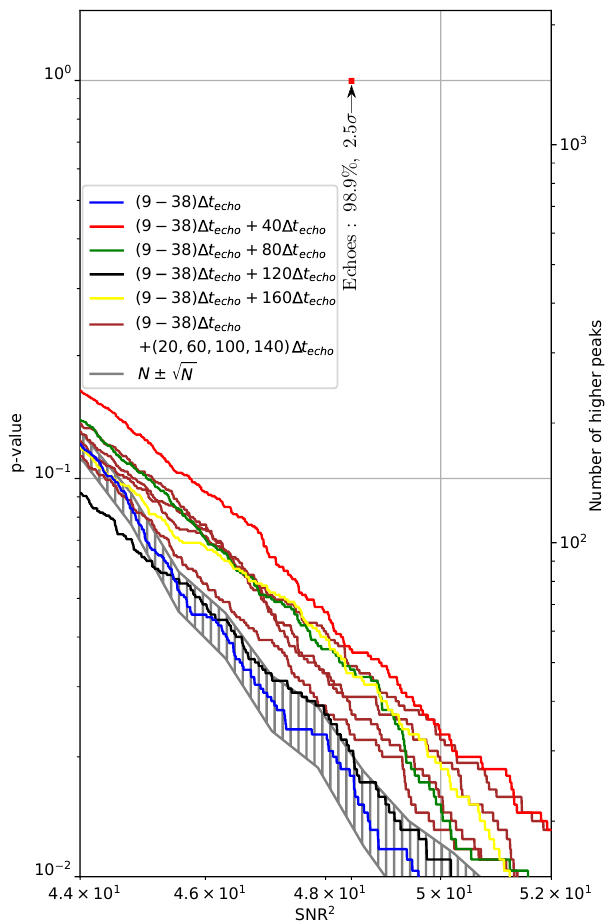
Figure 38. p -value distribution for combined events of different stretches of data within 1 min of the main events. Surprisingly, the blue line which is closest to the main event, and has used to define p -value in [18] (Figure 19), happens to give the smallest p -value. The shaded region represents the Poisson error range for blue histogram. This shows that the variation in p -values is clearly much larger. This behaviour is interpreted as non-gaussianity and/or non-stationarity of the LIGO noise. In this plot the y-axis on the left (right) shows p -value (number of higher peaks) within the mentioned range of data. In each histogram the total number of “peaks” is (38 9)/0.02 = −